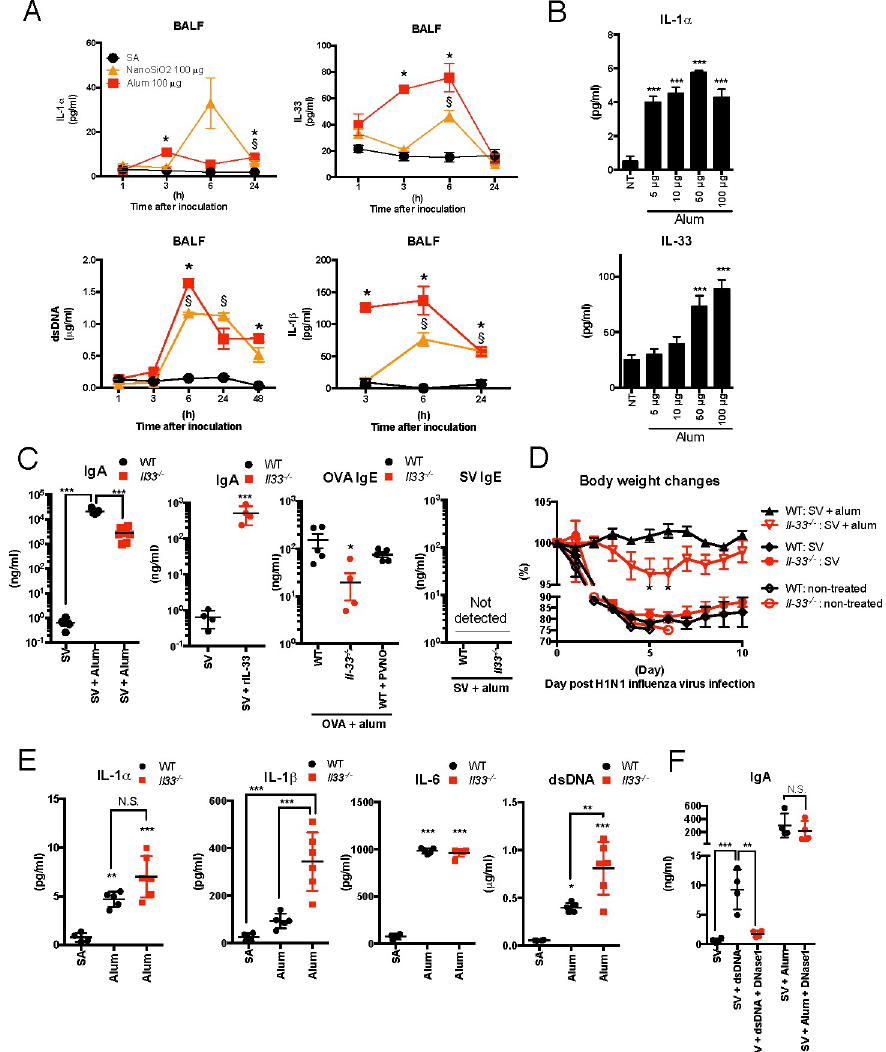
Fig 1. Alum has strong adjuvant effects in nasal influenza vaccines, and IL-33 has a significant influence on the induction of Ag-specific IgA Ab production by alum. ( A ) WT and IL-33-deficient ( Il33 -/- ) mice were intranasally administered SA, 100 μ g of alum, or 100 μ g of NanoSiO 2 . At 1, 3, 6, and 24 h after administration, the mice were euthanized, and BALF was collected. The concentrations of DAMPs in BALF were determined using ELISA. Quantification of dsDNA was performed using the Quant-iT Picogreen dsDNA Assay Kit. ( B ) For dosing amount- dependent responses, 5, 10, 50, or 100 μ g of alum was intranasally administered. BALF was collected 6 h and 24 h after alum intranasal administration to analyze IL-33 and IL-1 α levels using ELISA. Nontreated (NT) mice were used as controls. ( C ) BALF Ag-specific IgA Ab and serum IgE Ab concentration were determined using ELISA 14 days after the second immunization with SV, SV combined with alum, SV combined with rIL-33, OVA, or OVA combined with PVNO ( n = 4–6 per group). ( D ) Nonimmunized, SV-immunized, or SV plus alum-immunized WT or Il33 -/- mice were challenged with a 10 LD50 dose of A/Osaka/129/2009 [A(H1N1)pdm09] influenza virus 14 days after the second alum-adjuvanted SV immunization. Their body weight changes and survival were monitored ( n = 4–10 per group). ( E ) BALF was collected 6 h after SA or alum intranasal administration. IL-1 α , IL-1 β , and IL-6 concentrations in BALF were determined using ELISA, and quantification of dsDNA was performed using the Quant-iT Picogreen dsDNA Assay Kit ( n = 4–6 per group). ( F ) The mice were immunized with SV alone, SV with 2 μ g dsDNA, or SV with alum. In some groups, 600 IU of RNase-free recombinant DNase I was intranasally administered 3 h before and 18 h after each immunization. Another group was similarly administered PBS as a control for DNase I treatment. At 14 days after immunizations, the mice were euthanized, and BALF was collected to determine Ag-specific IgA Ab concentrations using ELISA ( n = 4 per group). The data are from two (A, B, C, E, and F) or three (D) independently performed experiments and are presented as the mean ( ± SEM). Each dot indicates the result of an individual animal (A, C, and D). For more than three groups, significance was assessed using one-way ANOVA and Dunnett’s multiple-comparison